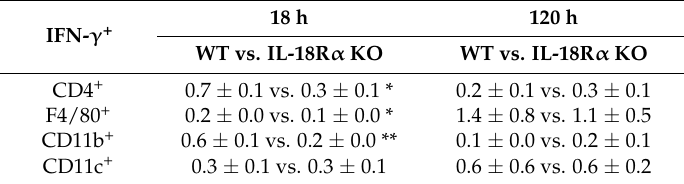
Table 2. Intracellular IFN- γ staining in CD4 + T cells and APCs after LPS-induced AKI.